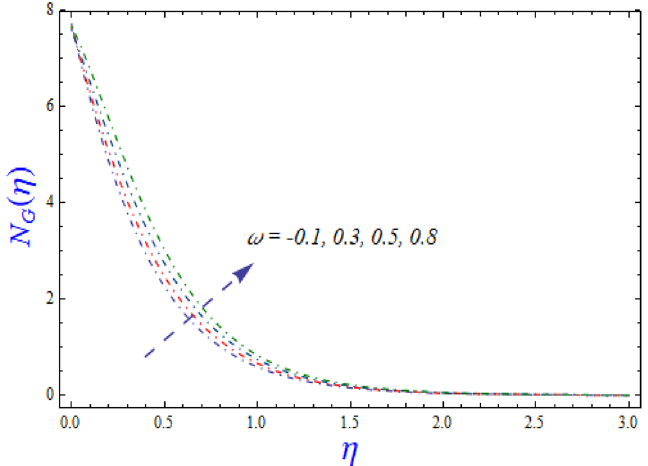
Figure 6. Effect of ω on N G (η) .